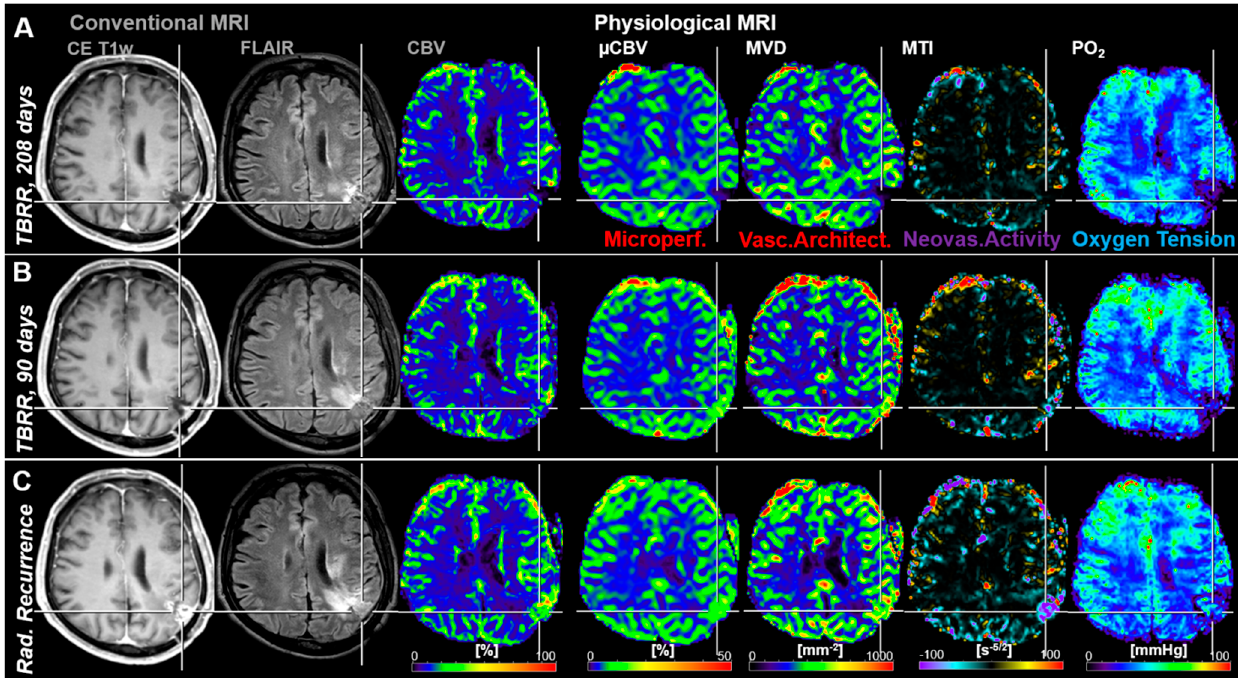
Figure 3. Follow-up MRI examinations of a 67-year-old male patient who developed local recurrence of an anaplastic astrocytoma (WHO Grade III). ( A ) The first follow-up examination (208 days before radiological recurrence) showed strong local hypoxia in the relevant region with low perfusion and microvascular architecture as well as without neovascularization activity. ( B ) In the second follow-up MRI examination, 118 days later and 90 days prior to radiological recurrence, a slight increase in microvascular perfusion, microvascular architecture, neovascularization activity, and local tissue oxygen tension was observed in this brain region. ( C ) This resulted in radiological recurrence detection of the AG another 90 days later. Repeat craniotomy revealed malignant transformation to glioblastoma. TBRR = time before radiological recurrence.